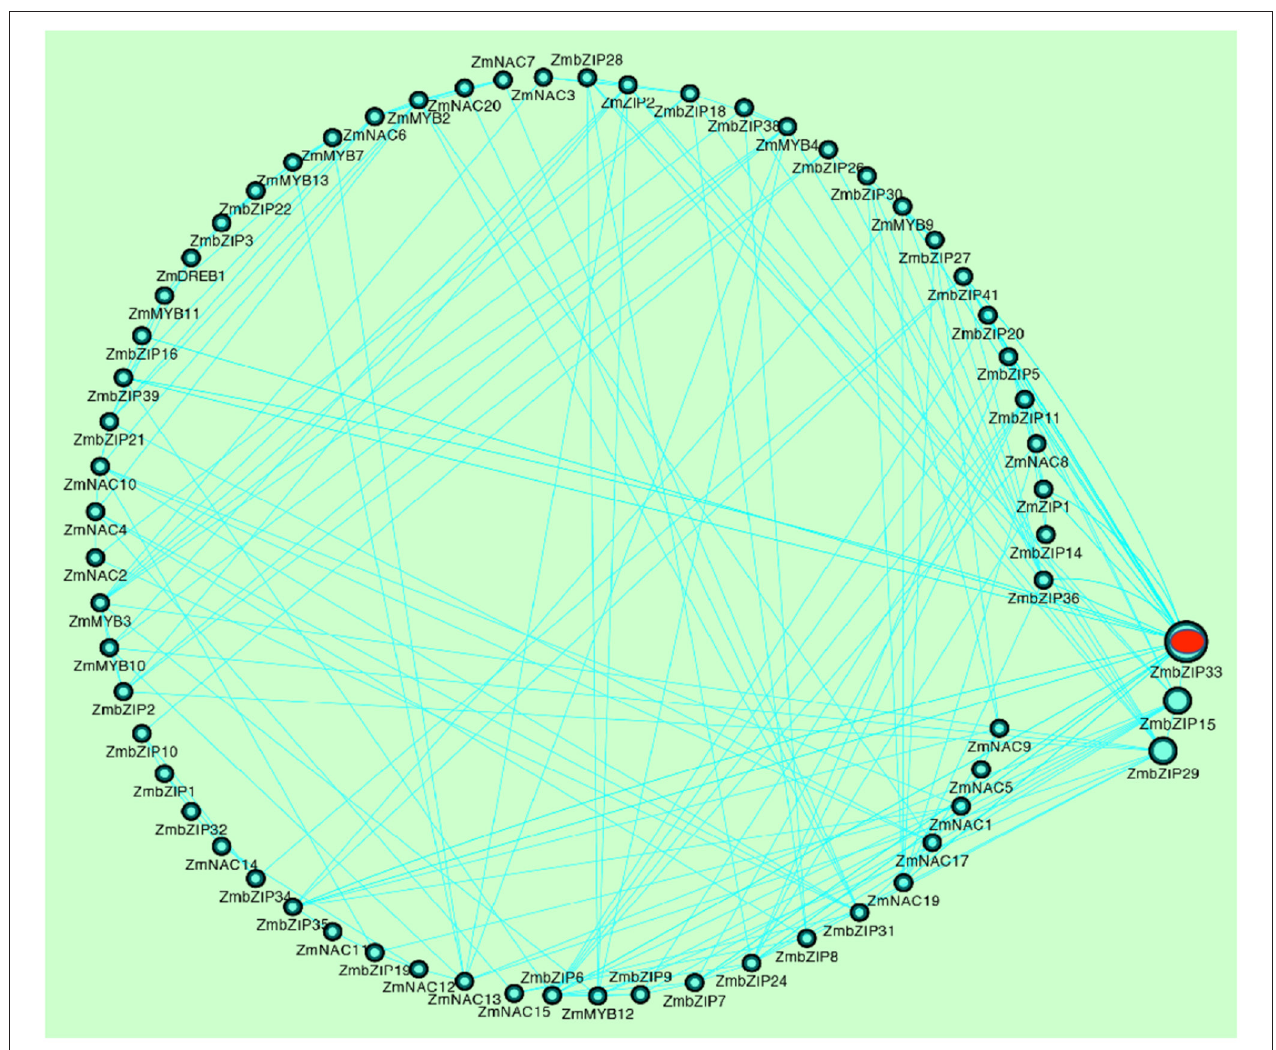
FIGURE 2 | The gene co-expression network of TFs. The gene co-expression network between 77 TFs was constructed by Cytoscape software (correlation coefficient is greater than 0.75). The straight line represents a correlation between genes. The circle represents the TFs, and the larger the circle, the more connected to other